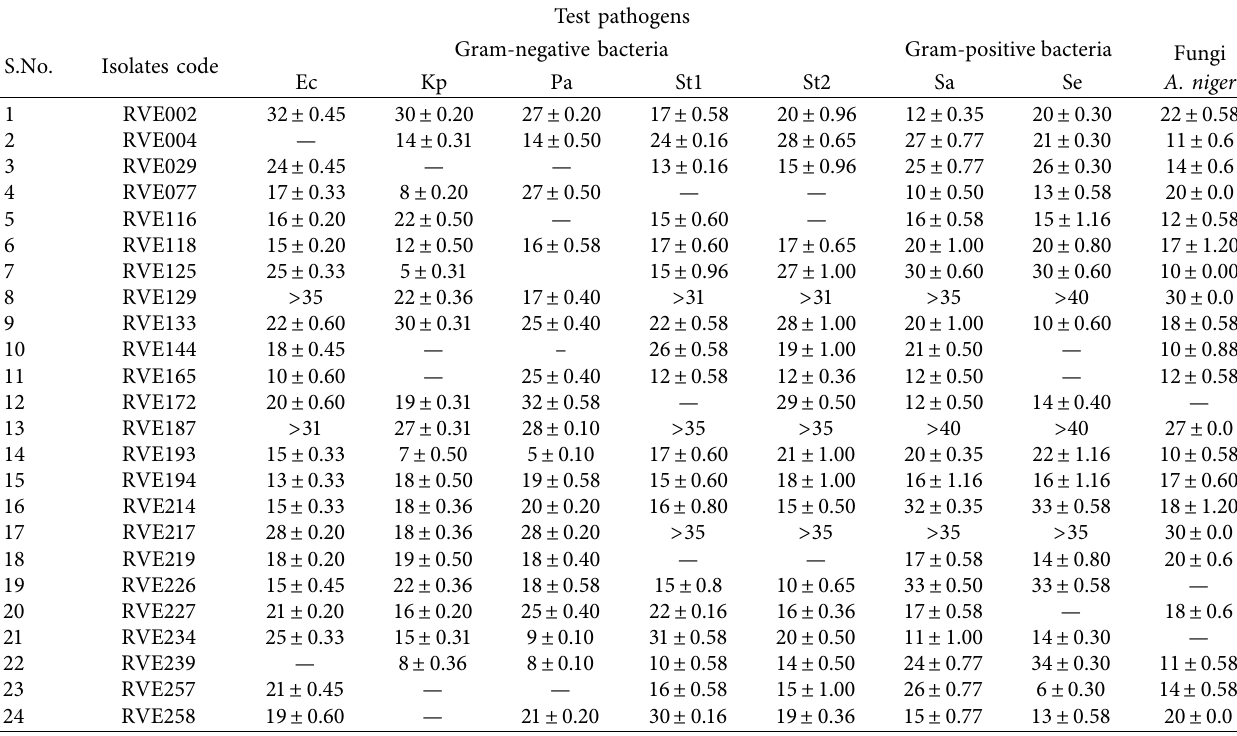
Table 2: Inhibition zone of the actinomycete isolates against the test